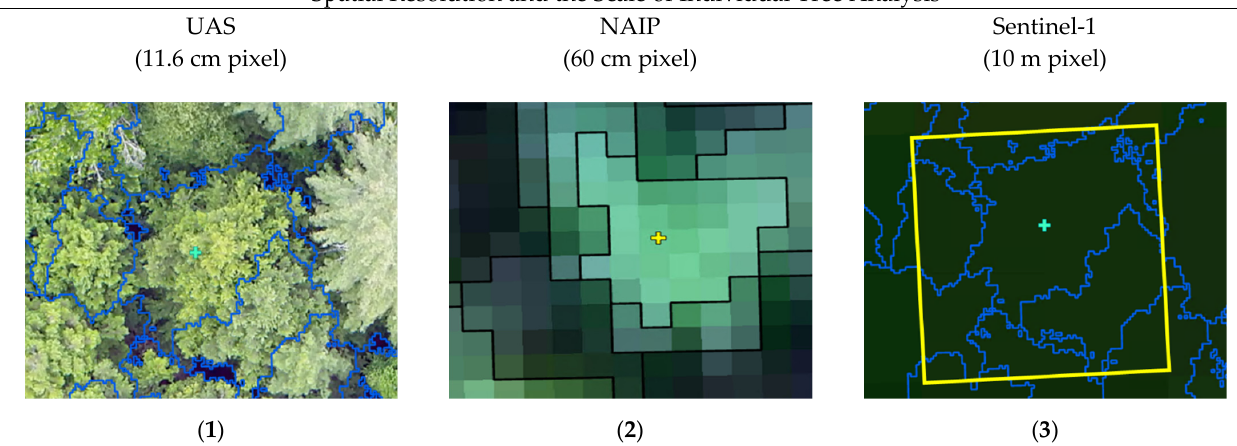
Figure 5. Characterization of individual trees using three sources of remotely sensed imagery. ( 1 ) UAS natural color imagery, segmented to provide an analysis of a singular Eastern hemlock ( Tsuga canadensis ). ( 2 ) NAIP imagery, segmented to analyze this same tree. ( 3 ) Setinel-2 imagery, depicting a singular 10 m pixel (in yellow) overlaid on the UAS segmented individual tree crowns.